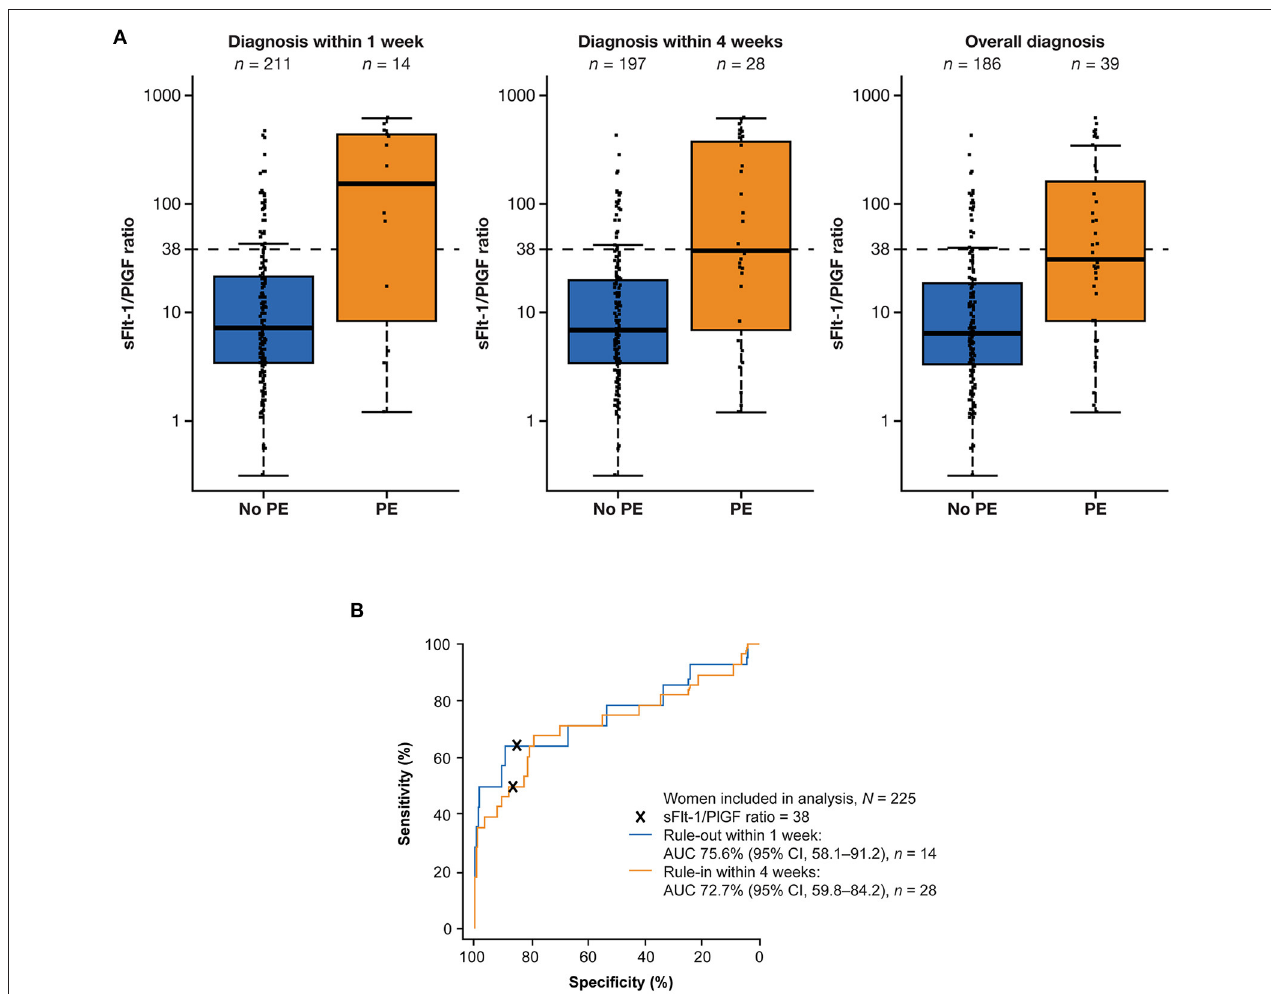
FIGURE 1 | Performance of the sFlt-1/PlGF ratio for predicting preeclampsia within 1 and 4 weeks. (A) Distribution of sFlt-1/PlGF ratios at baseline for participants who developed or did not develop preeclampsia within 1 week, within 4 weeks, and overall. a (B) Performance of the ratio for ruling out preeclampsia within 1 week (blue) and ruling in preeclampsia within 4 weeks (orange). a The boxes represent the first and third quartiles and the median value. The whiskers represent values that are 1.5 × the IQR or shorter in cases where the minimal/maximal value lies within 1.5 × the IQR in log scale. AUC, area under the curve; CI, confidence interval; IQR, interquartile range; PE, preeclampsia; PlGF, placental growth factor; sFlt-1, soluble fms-like tyrosine kinase 1.